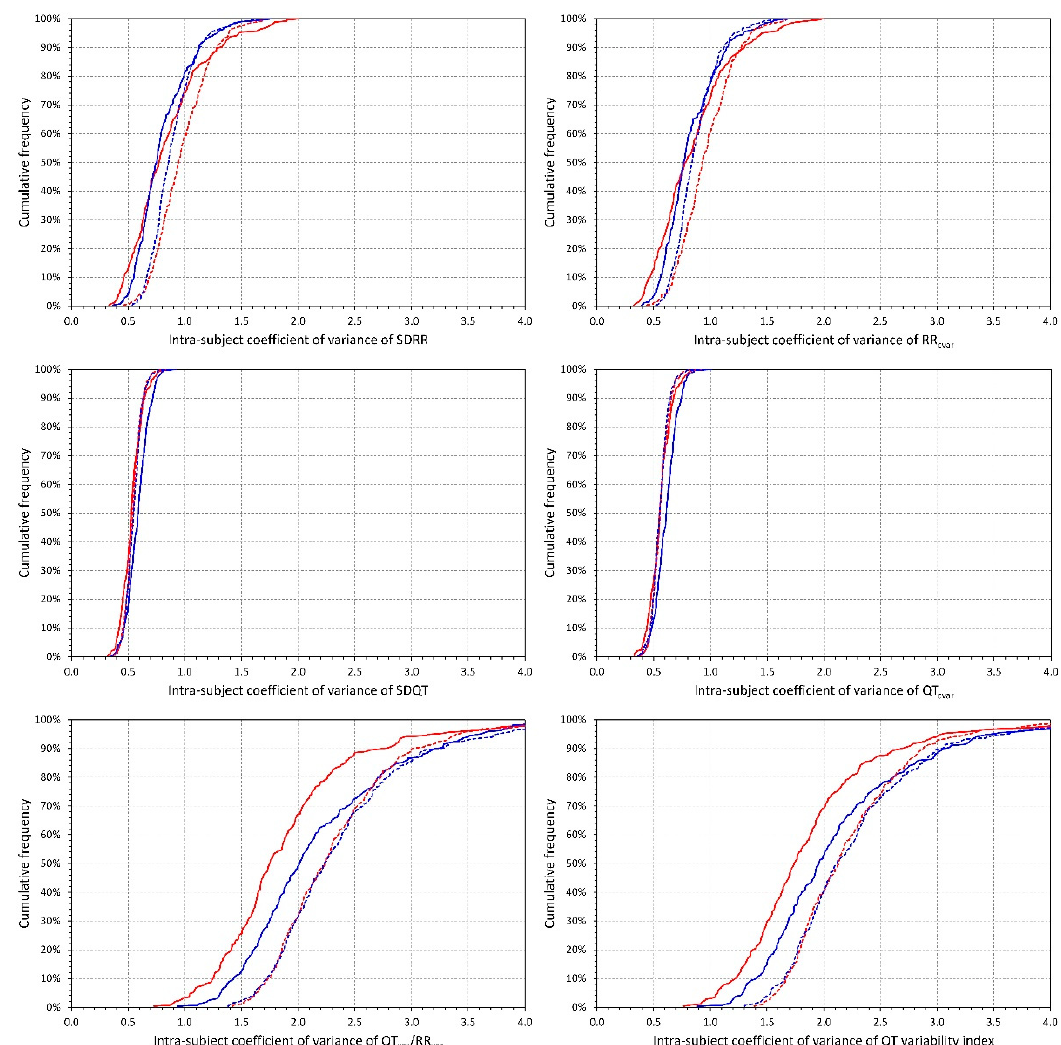
Figure 3. Intra-subject coe ffi cients of variance. For each of the investigated indices (see the labels of the horizontal axes of individual panels) the figure shows the cumulative distributions of intra-subject coe ffi cient of variance of the given index calculated over ECGs with heart rate between 50 and 75 bpm (full lines) and between 75 and 100 bpm (dashed lines). The red and blue lines correspond to female and male subjects,